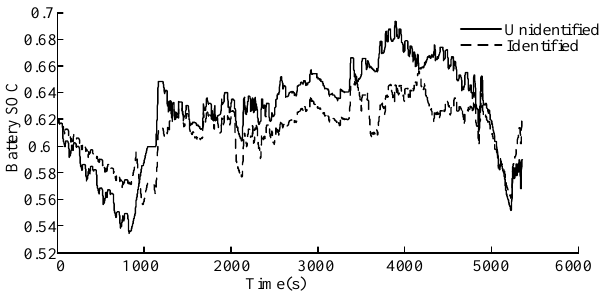
Figure 14. Variation of SOC under comprehensive driving cycle conditions.